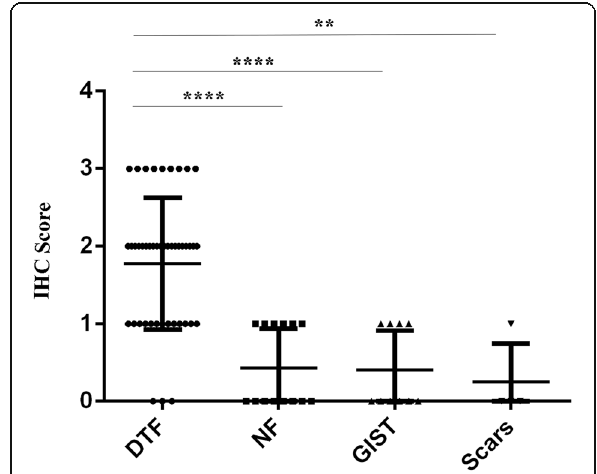
Fig. 5 Immunohistochemical results of TFE3 expression in DTF, NF, GIST and scars tissue samples. Quantitative analysis of TFE3 expressions were revealed by immunohistochemical score. Data are presented as mean± SEM. Levels of significance between DTF and other groups were calculated by Mann-Whitney U test (** P <0.01 and **** P <0.0001)